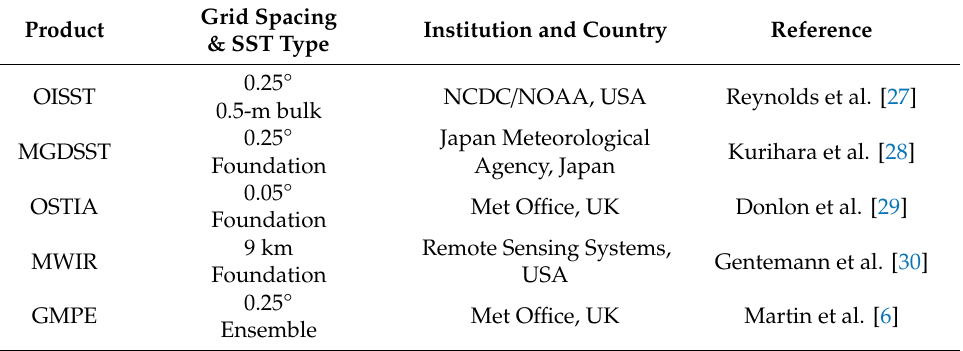
Table 1. Characteristics of the global gridded sea surface temperature (SST) products.